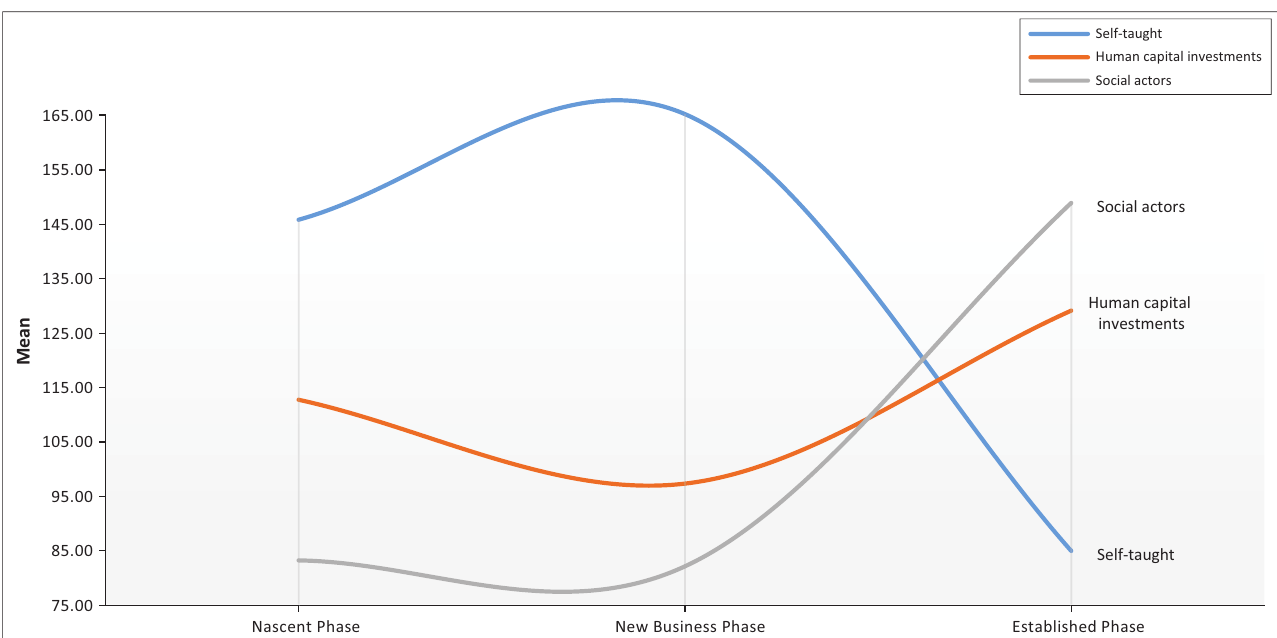
FIGURE 3: Sources of skills across the entrepreneurship